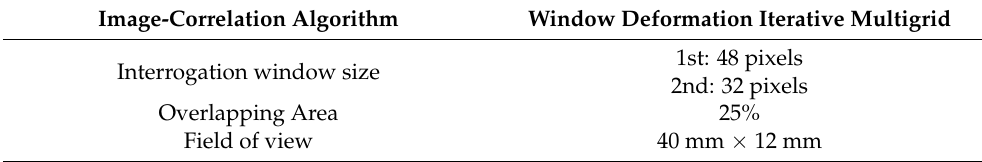
Figure 6. Experimental setup for the BOS measurement system. Table 2. Conditions for calculating the displacement field.